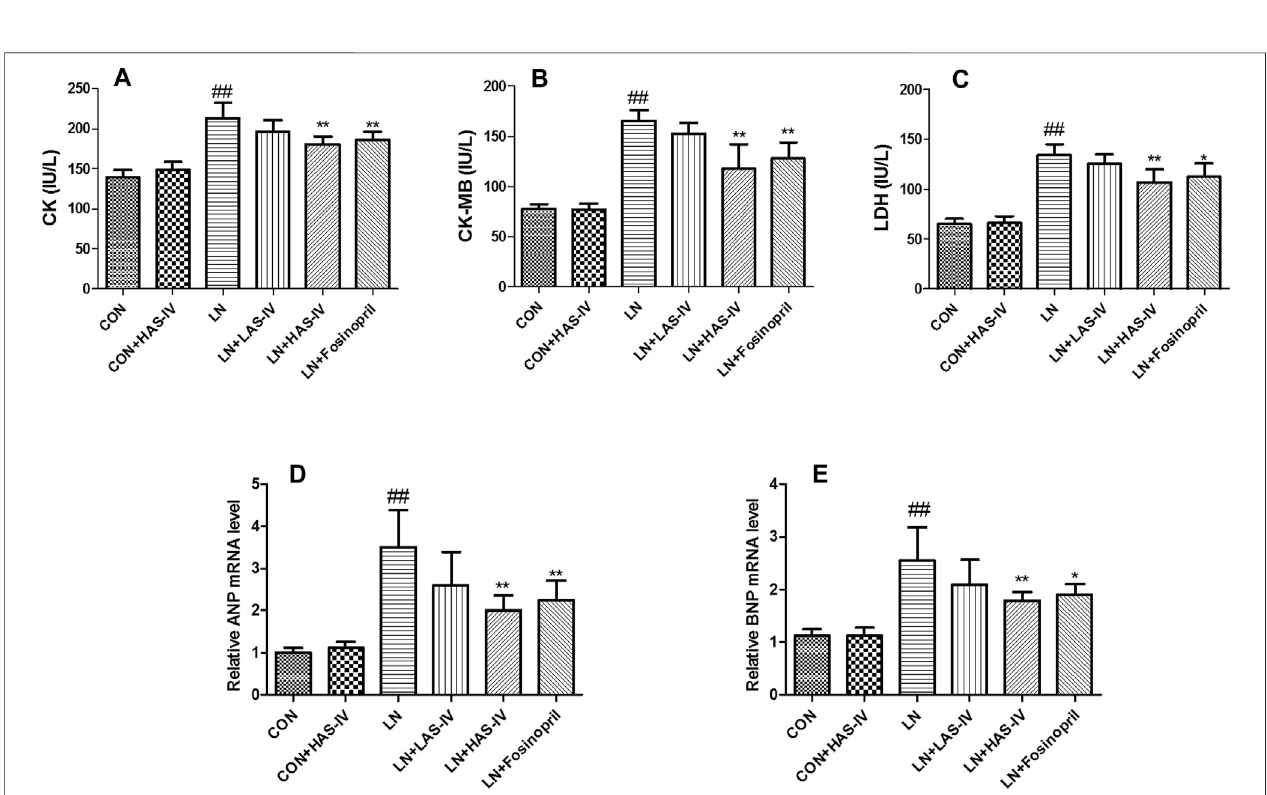
FIGURE 5 | Effects of Astragaloside IV (AS-IV) on cardiac marker enzymes and cardiac hypertrophy in L-NAME-treated rats. The serum CK (A) , CK-MB (B) , LDH (C) activities were measured by commercially available kits. The cardiac tissue ANP (D) , BNP (E) mRNA expression levels were measured by qRT-PCR. Results were shown as mean ± SD ( n (cid:1) 6 for each group). ## p < 0.001 versus CON group; * p < 0.01 versus LN group; ** p < 0.01 versus LN group; *** p < 0.001 versus LN